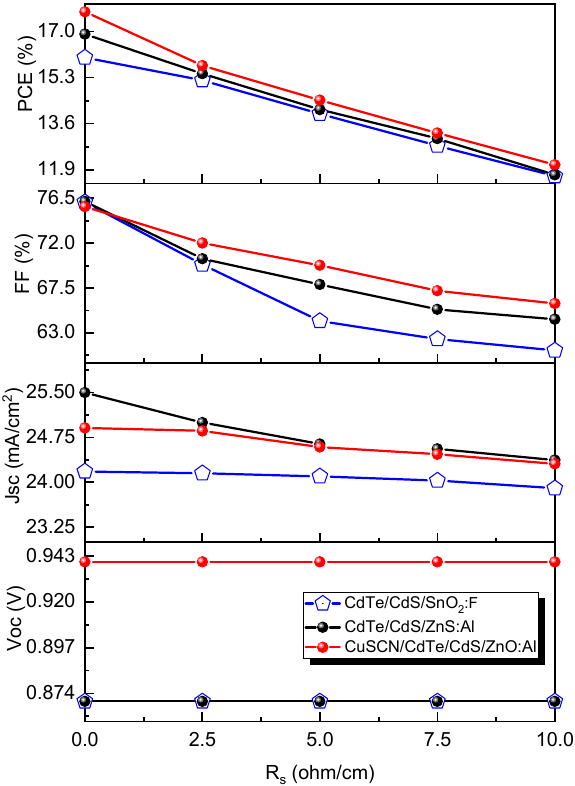
Figure 11. Effect of series resistance (R s ) on the CdTe solar cells.